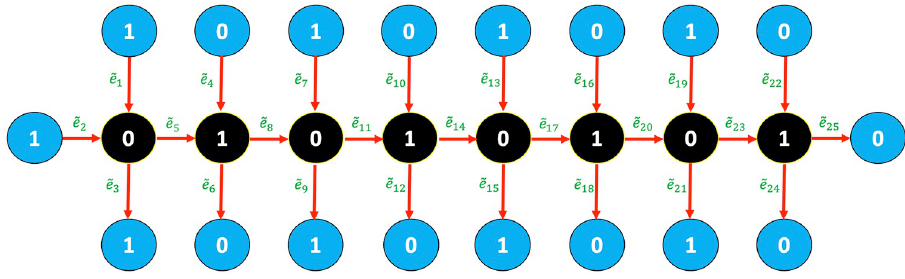
Fig 4. A structure of an octane compound C 8 H 18 with labeled vertices 0 or